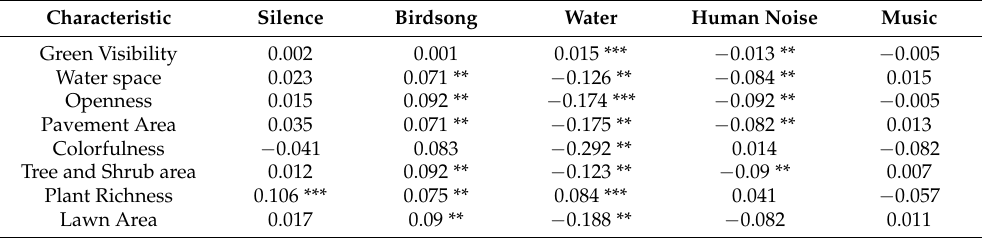
Table 5. Standardized direct effects of environmental characteristic on mental restoration.